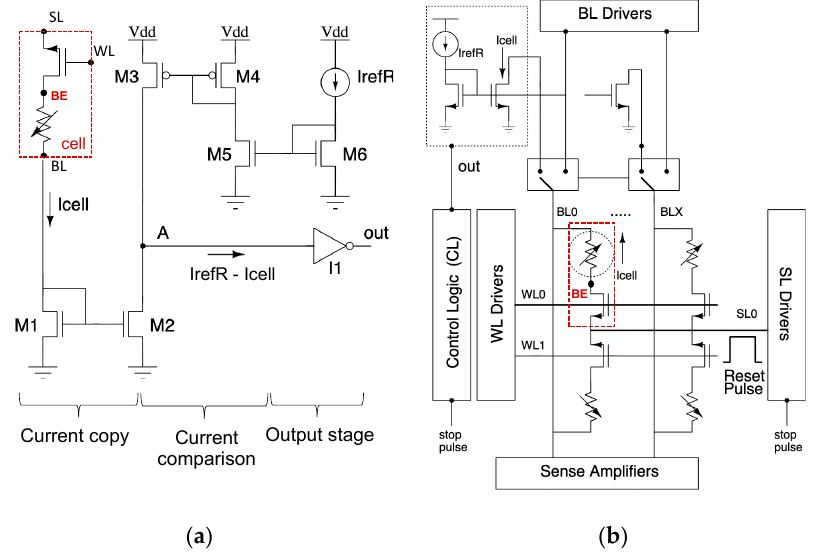
Figure 7. ( a ) Self-terminating write driver for RST operations ( b ) RST write termination implementation. During the RST operation, the RRAM cell current I cell is copied by an n-MOS current mirror (M1, M2). The current mirror (M3, M4) is used to mirror the reference current I